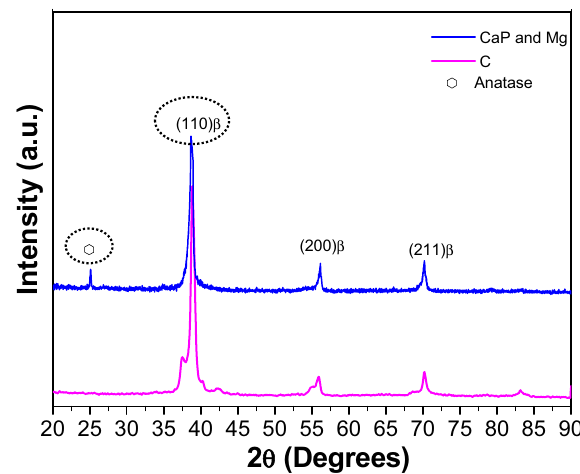
Fig. 2 XRD analysis of C, CaP and Mg groups with a predominance of the β phase and presence of anatase in CaP and Mg groups